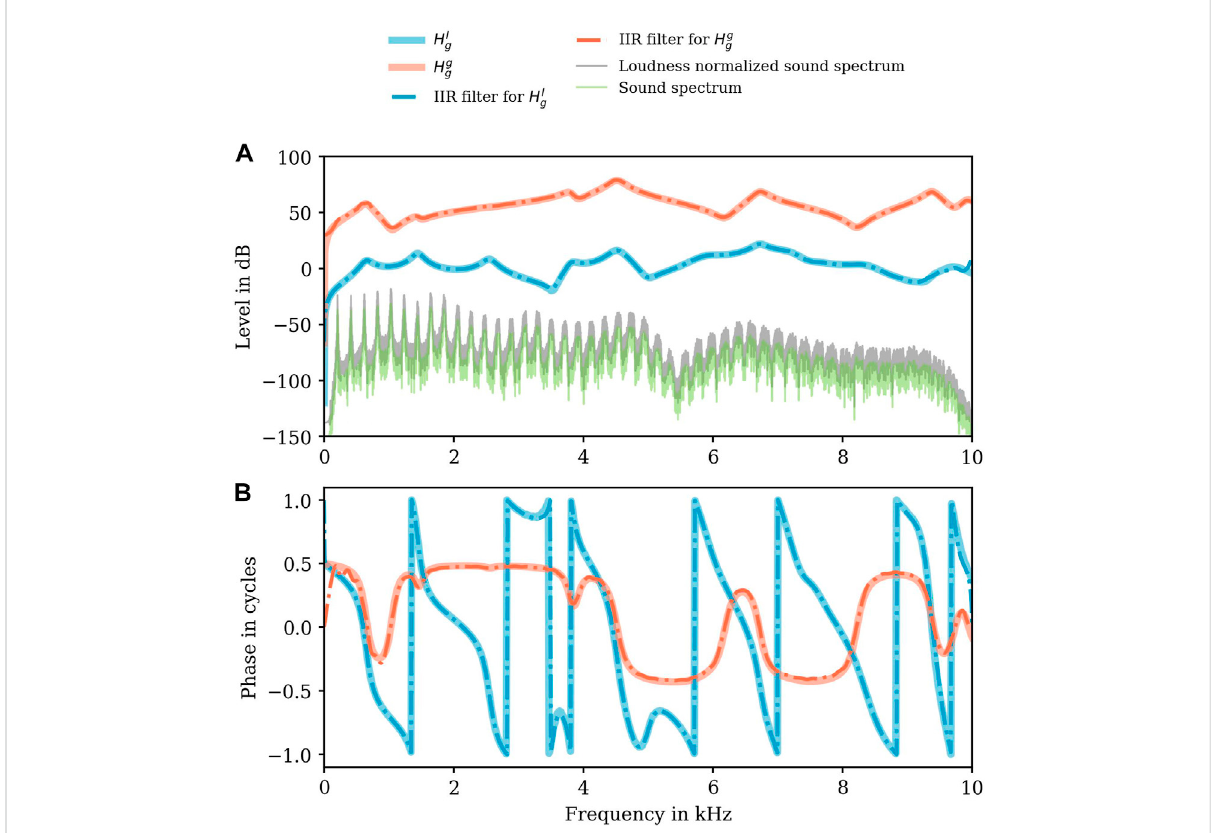
Supplementary Data Sheet S1). Slight downward